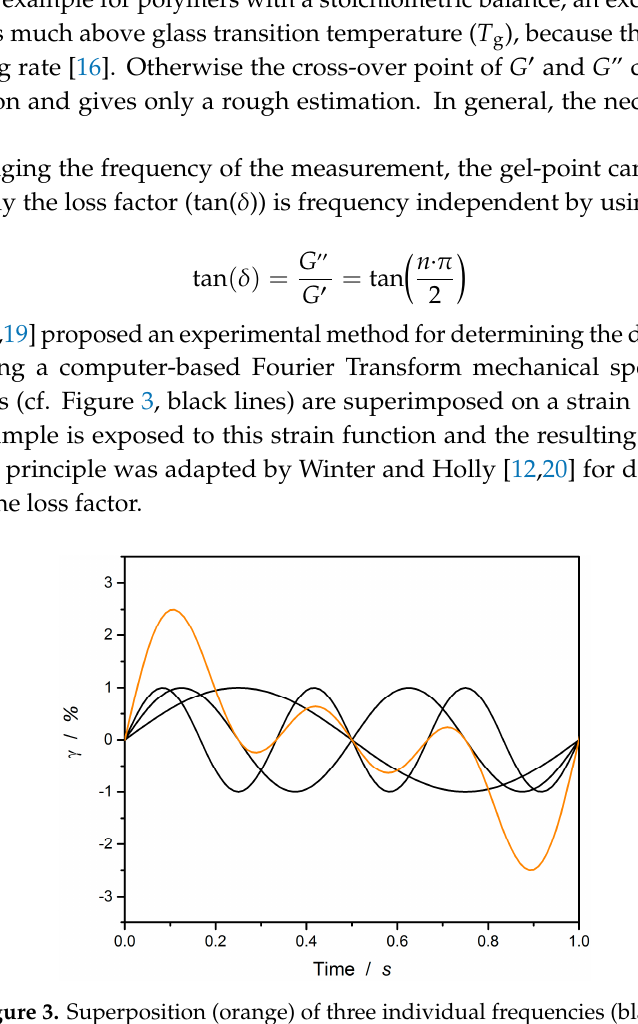
Figure 3. Superposition (orange) of three individual frequencies (black).